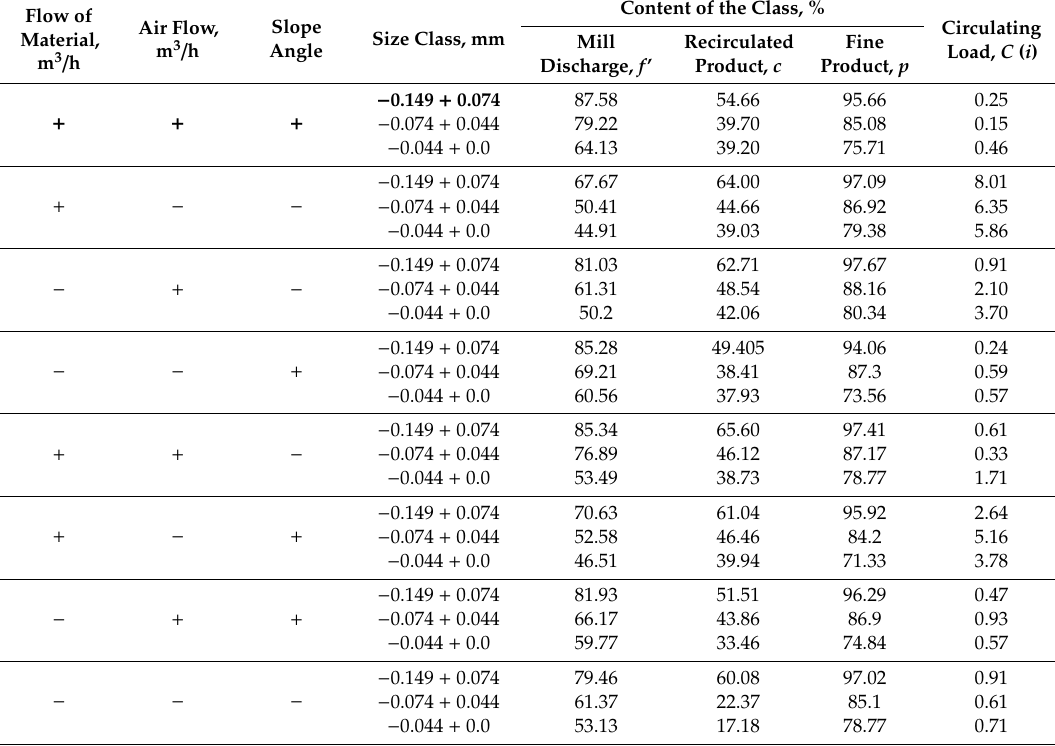
Table A1. Calculation of the circulating load in the grinding circuit.